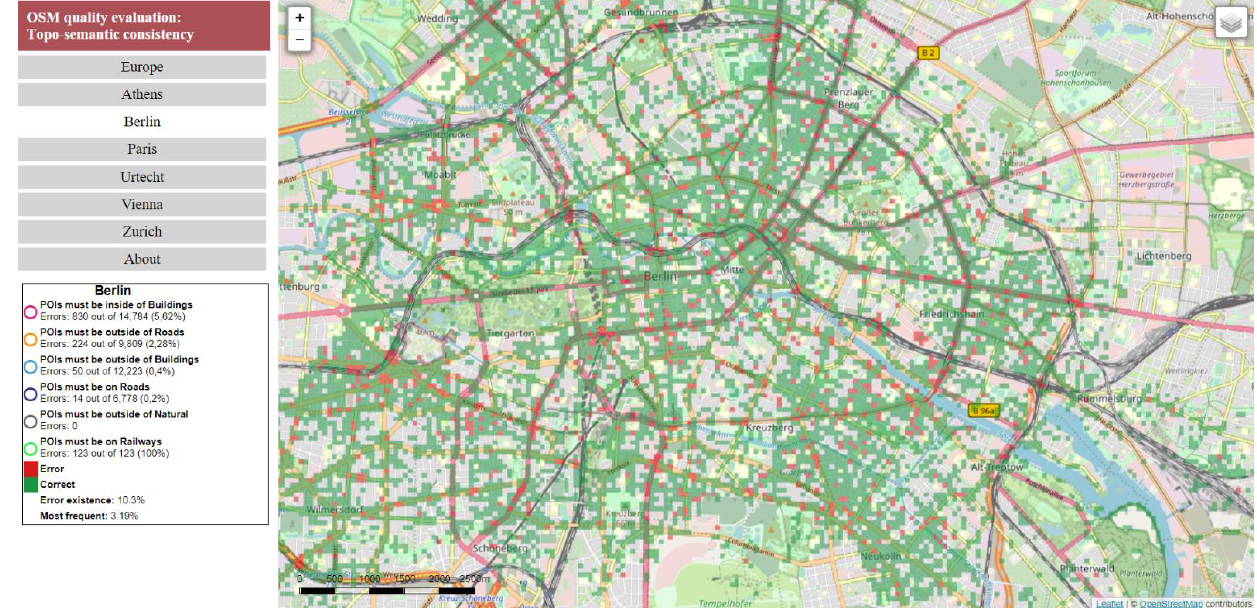
Figure A4. Consistency Grid (error existence) for Berlin.